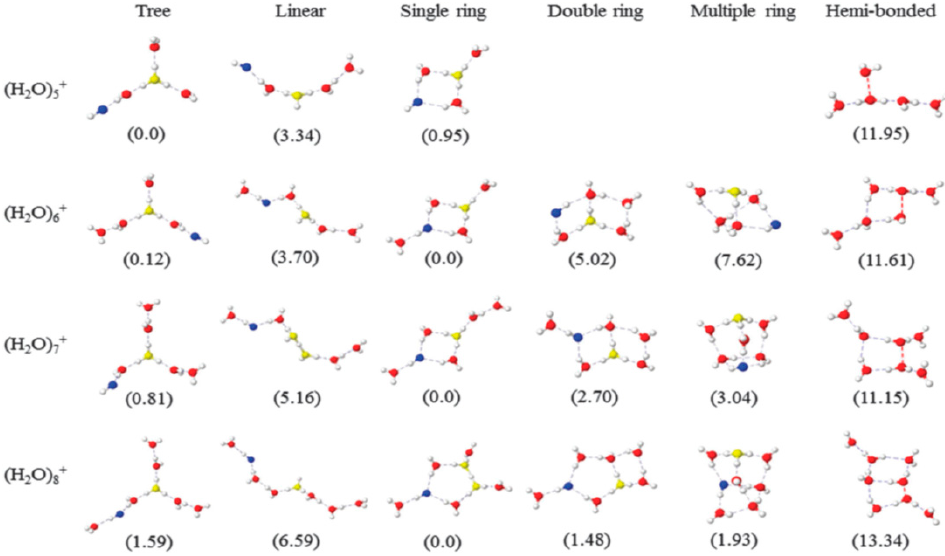
Figure 26. The most stable structures of (H 2 O) n+• in different topological groups, as determined using ab initio methods. To guide the eyes, the O atoms of H 3 O + , the •OH radical and H 2 O are shown in yellow, blue and red. The relative energies with zero-point energy (ZPE) correction (in kcal/mol) are shown in parentheses. Figure adapted from [102] with permission. Copyright 2014 The Royal Society of Chemistry.